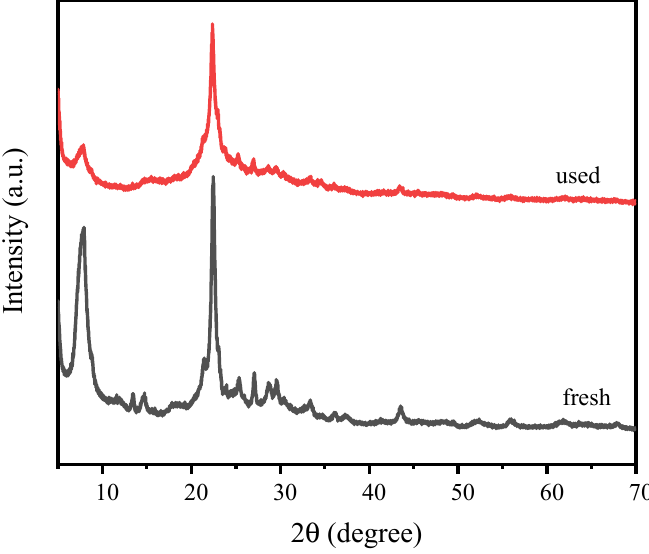
Figure 15. XRD patterns of fresh and used Bi/ β -2 catalyst.